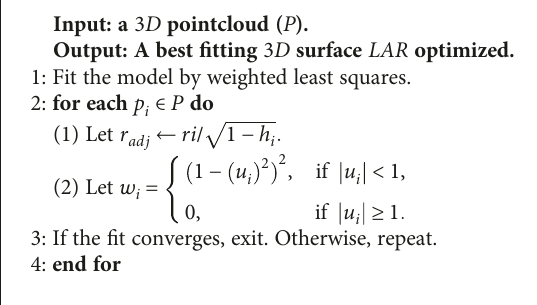
Algorithm 4: Minimum LAR 3D surface algorithm.